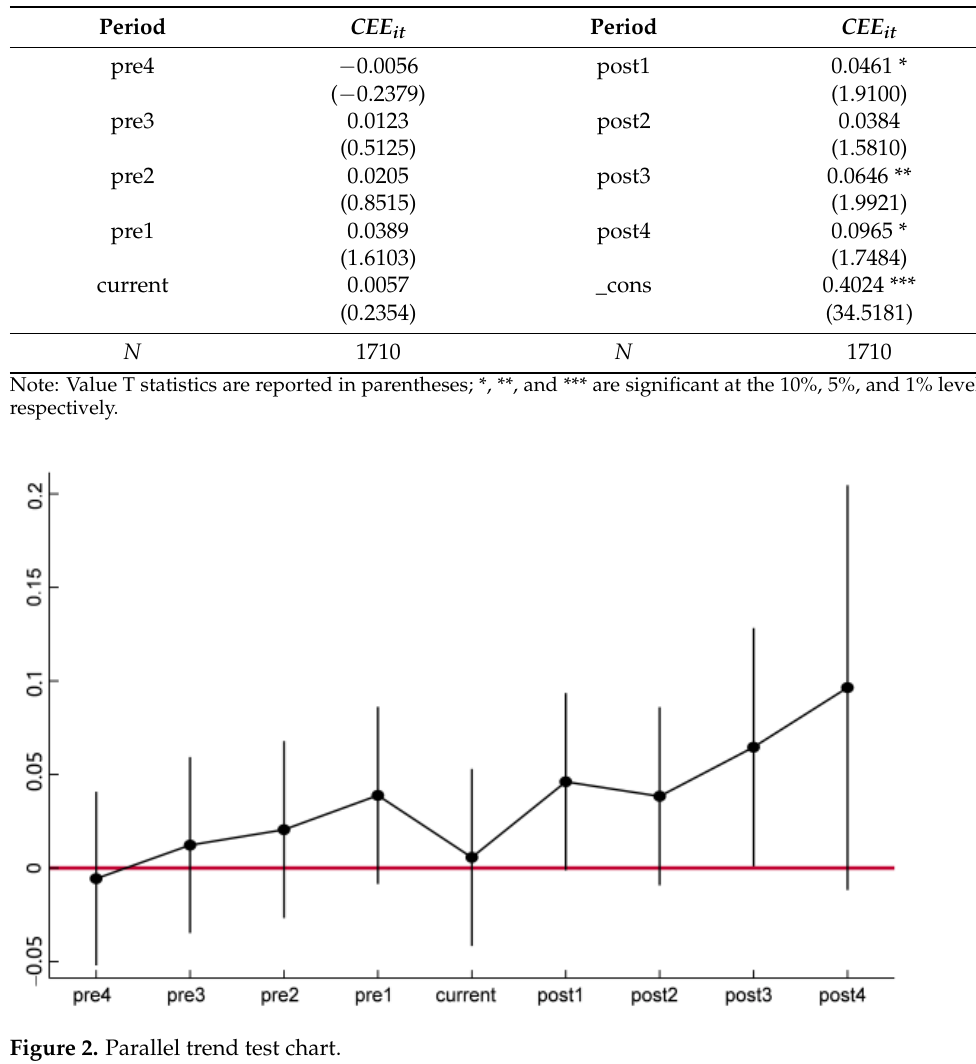
Table 4. Parallel trend test regression results.